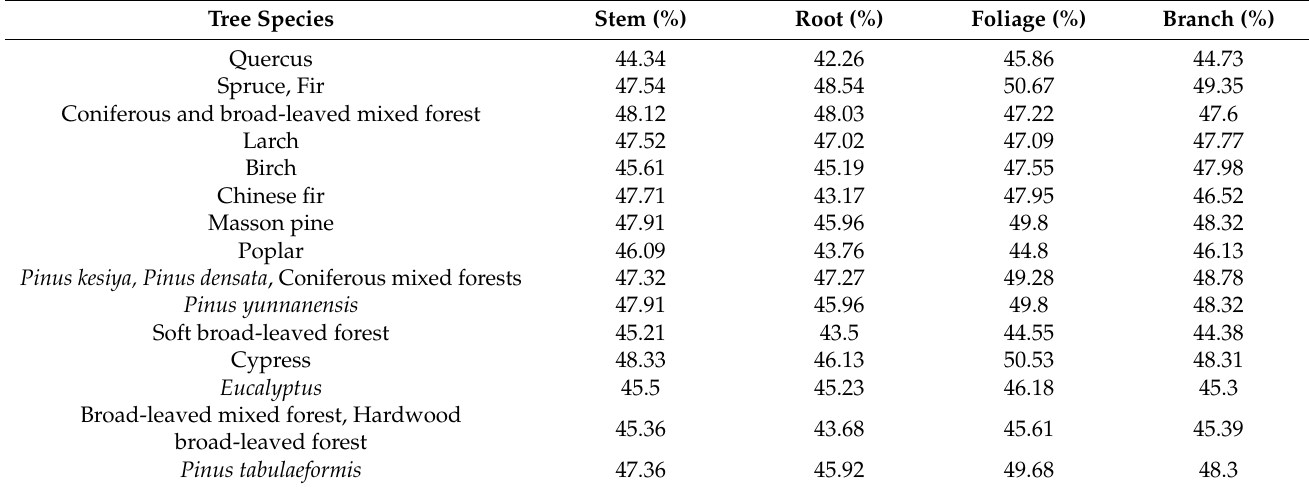
Table 2. The carbon content of different organs of tree